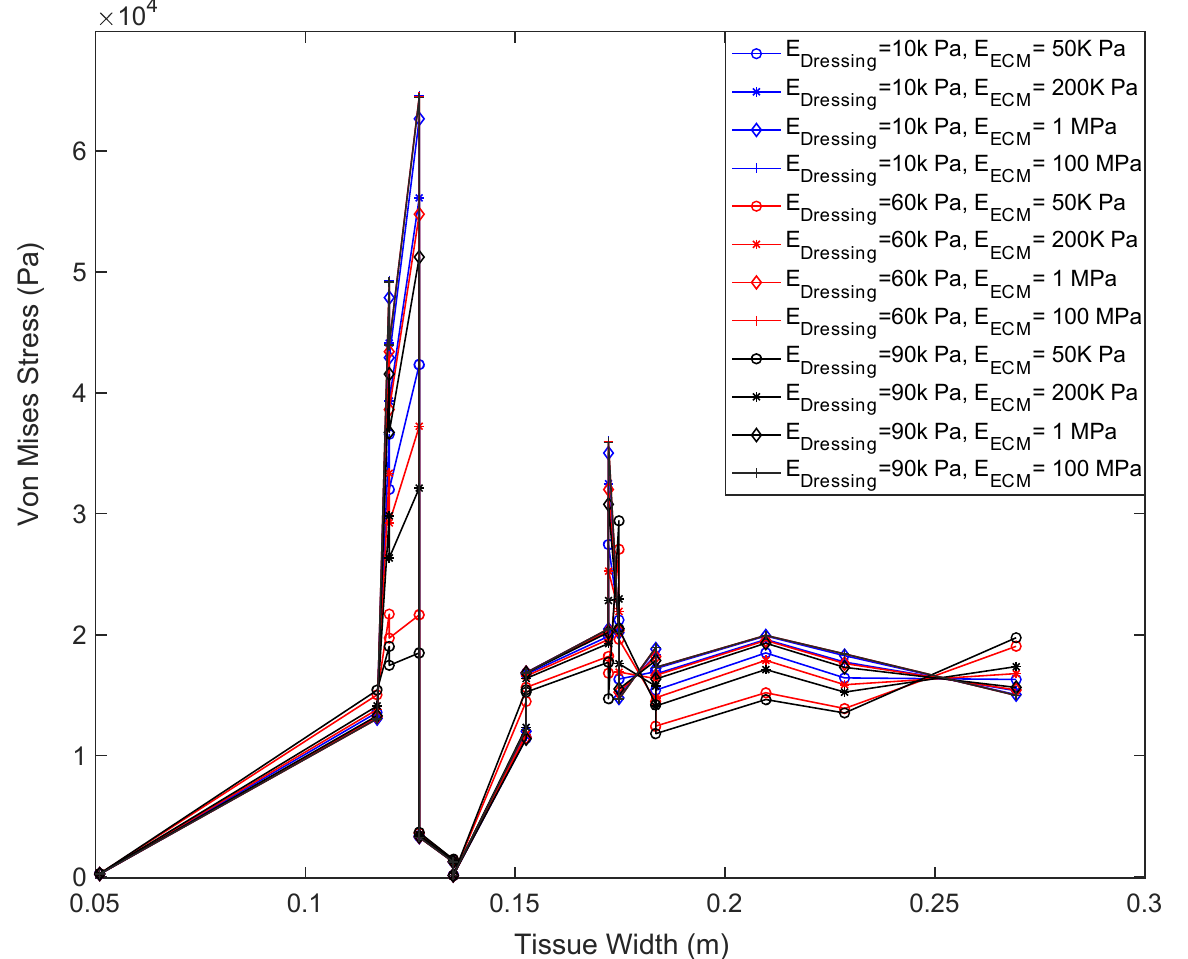
Figure 3. The von Mises stress values in accordance with the location on the tissue surface when dressing length is maintained at 7 cm.